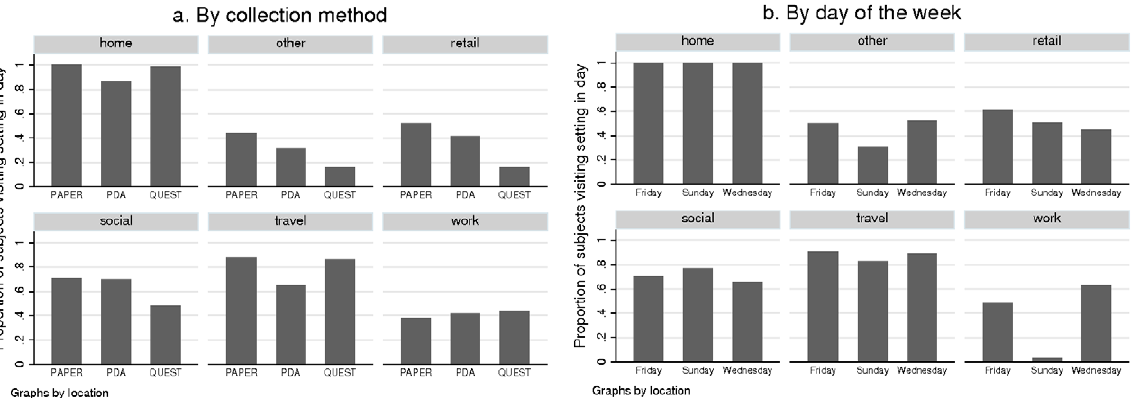
Figure 1. Recorded presence in each setting category. a) Average proportion of subjects reporting presence in each setting category by collection source. b) Proportion of subjects reporting presence in each setting category by day for paper diary only.